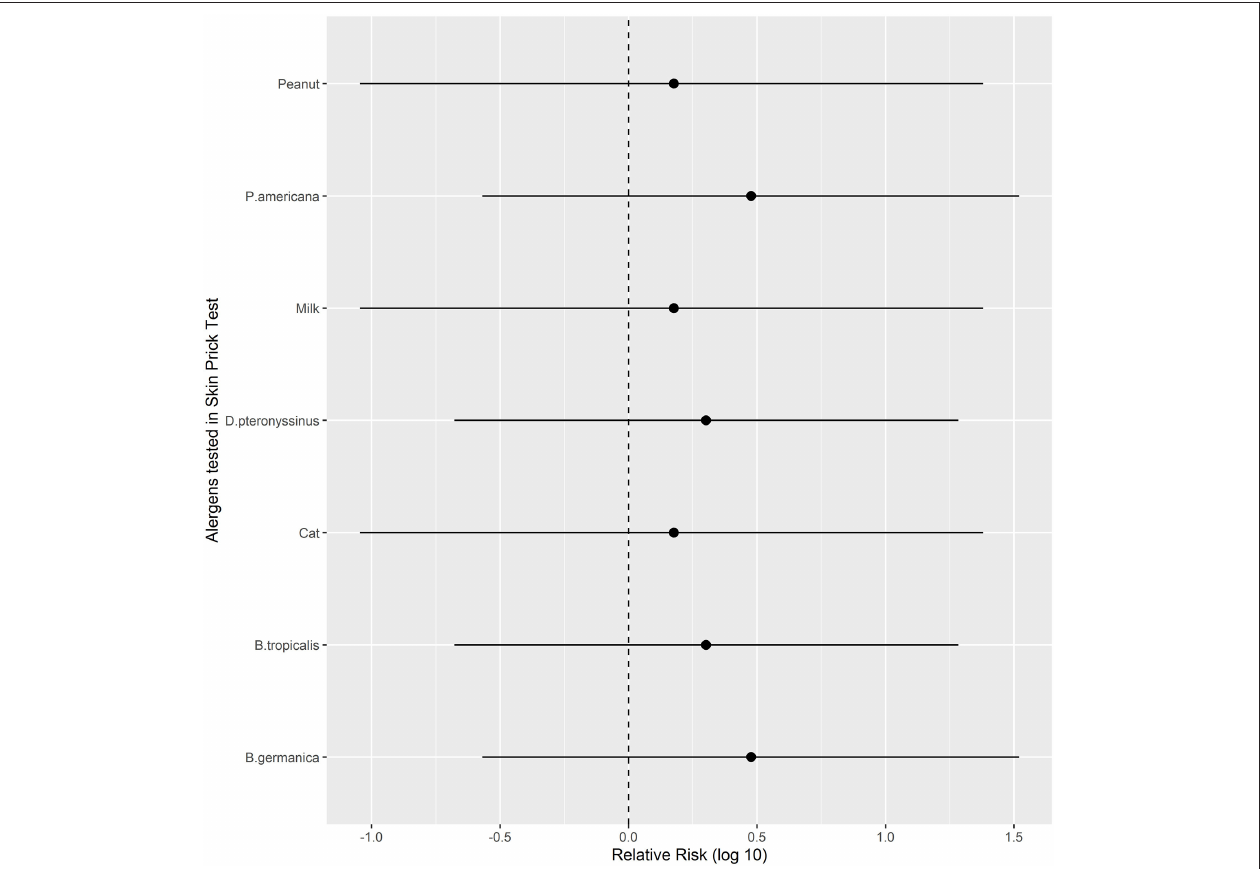
FIGURE 4 | Relative risks (with 95% confidence intervals, log-transformed) of improvement in SPT results in the Probiotics group vs. Placebo for different antigens at the end of follow-up (T12). Bg, Blatella germanica ; Bt, Blomia tropicalis ; Dpt, Dermatophagoides pteronyssinus ; Pa, Periplaneta americana